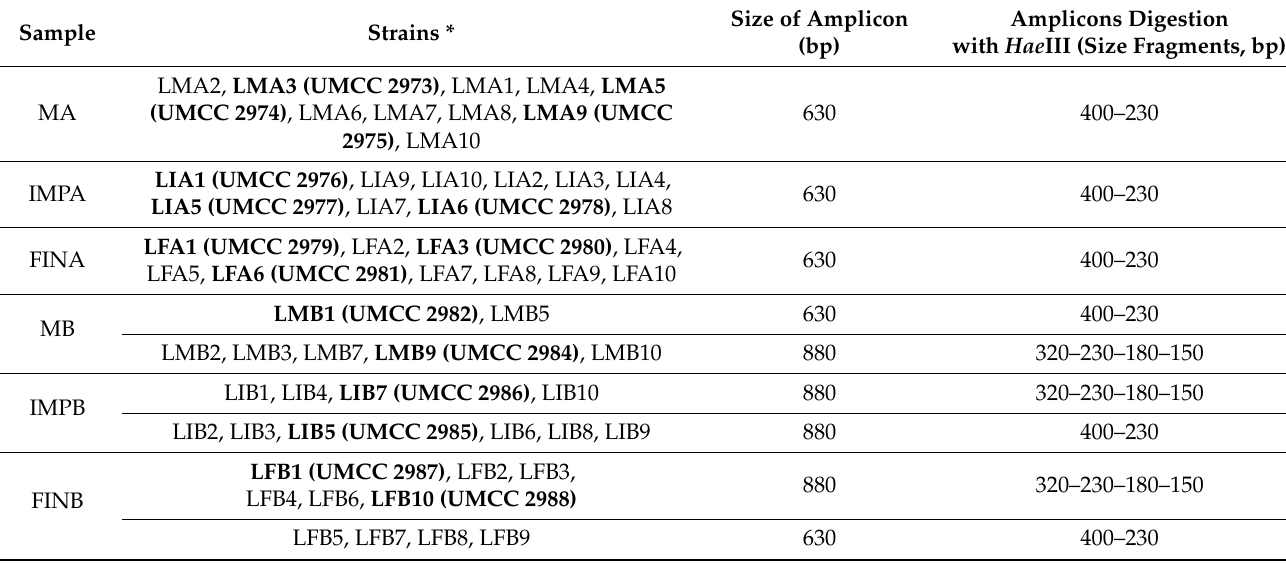
Table 3. RFLP-PCR of ITS-5.8S